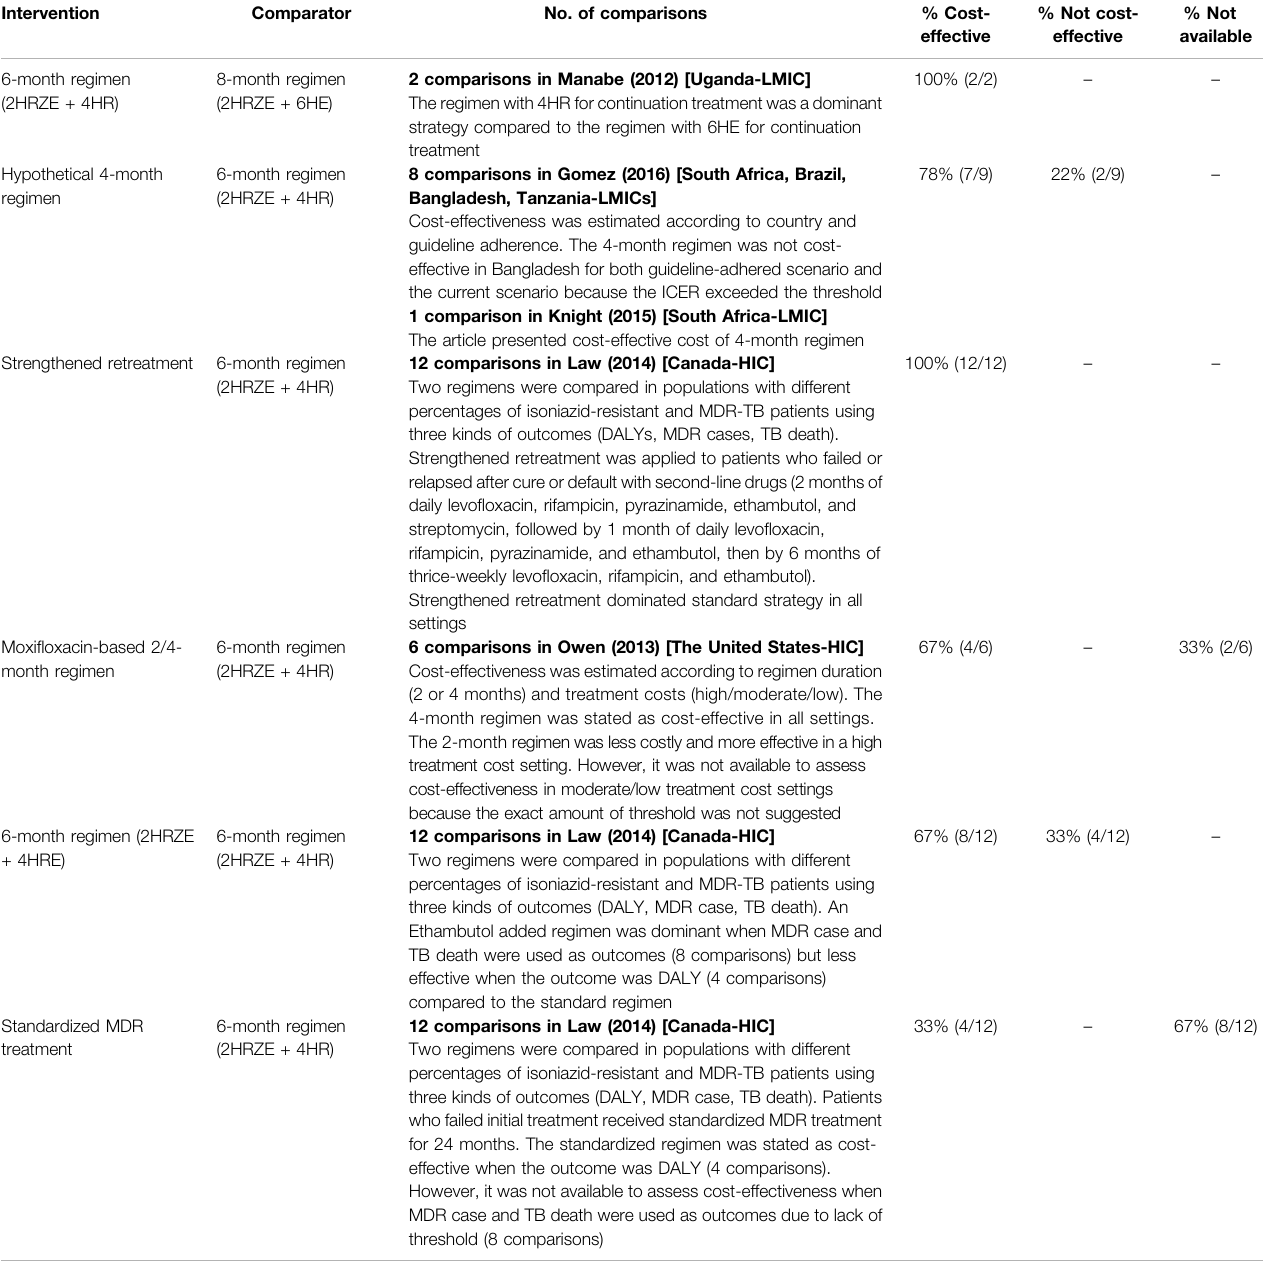
TABLE 2 | Cost-effectiveness of interventions in studies comparing regimens/drugs of drug susceptible/treatment-naïve TB